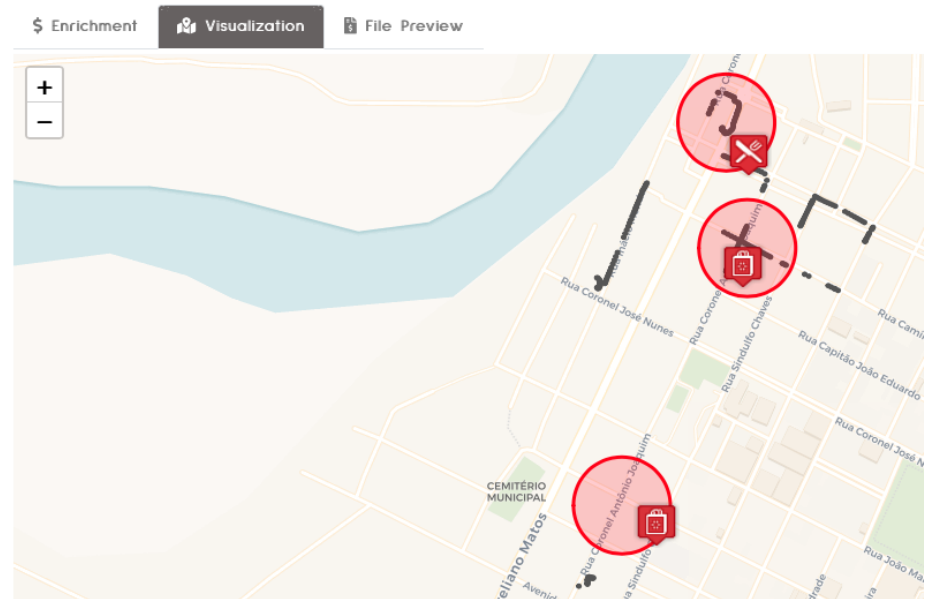
Figure 9. Interface after executing the semi-automatic semantic